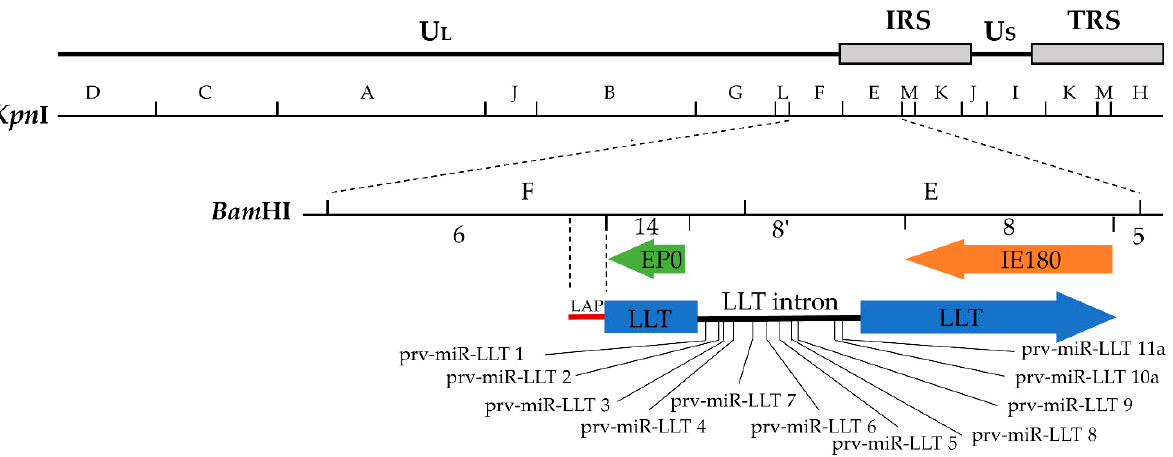
Figure 1. Schematic of the PRV genome and location of the LAT gene. The images from top to bottom show the structure of the PRV genome, the Kpn I restriction enzyme map, the Bam HI restriction enzyme map, the transcription location and direction of LAT, IE180, and EP0 genes, the LAP location, and the location of prv-miR-LLT 1-11 in the LLT intron.